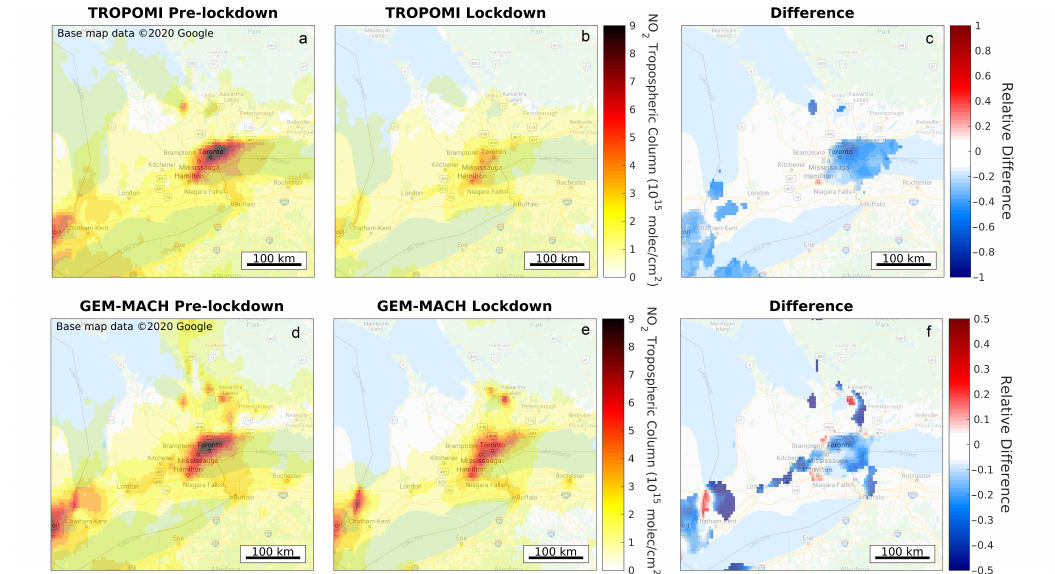
Figure 1. TROPOMI averaged VCDs over southern Ontario are shown for ( a ) a pre-lockdown (16 February–15 March 2020) and ( b ) a lockdown (16 March–8 May 2020) period. The relative differences ((lockdown-pre-lockdown)/pre-lockdown) are shown in panel ( c ) for areas that exceed 3 × 10 15 molec/cm 2 in the pre-lockdown period. Panels ( d – f ) are the same but for the operational GEM-MACH model BAU NO 2 VCDs, sampled at the time and location of the TROPOMI